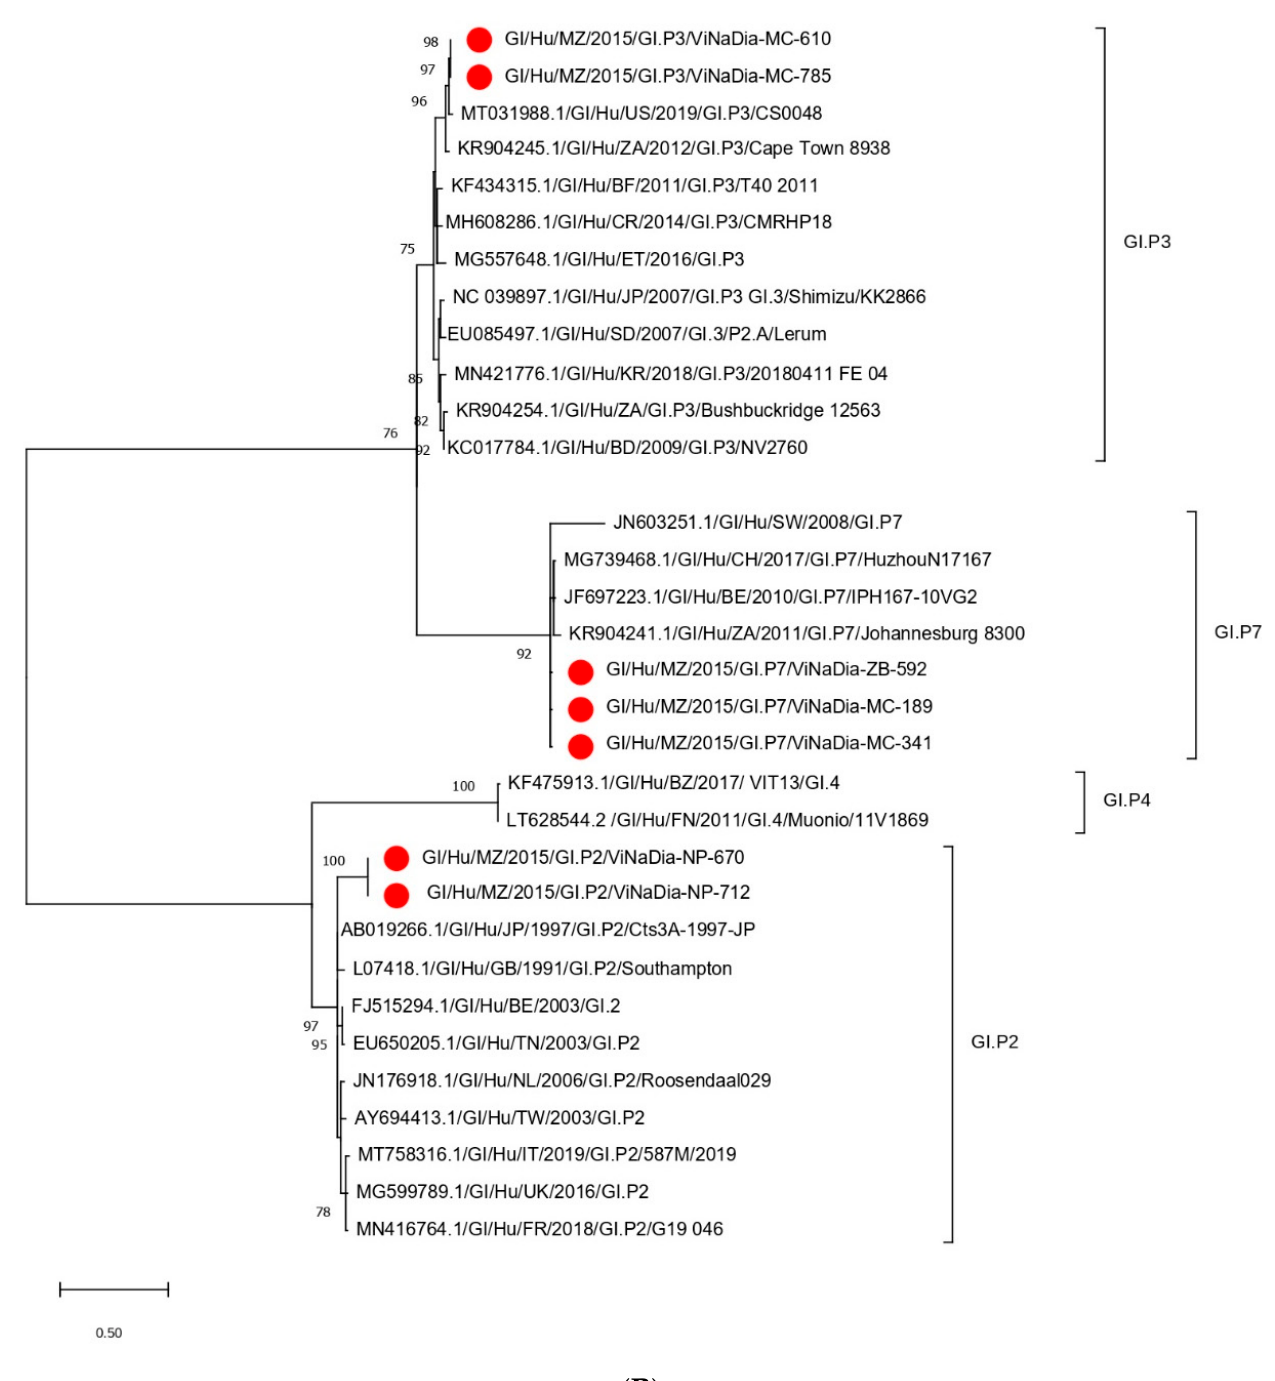
Figure 3. ( A ) Maximum-likelihood phylogenetic tree of partial VP1 gene (region C), representing seven NoV GI strains and three genotypes from Mozambique, and ( B ) maximum-likelihood phylogenetic tree of partial RdRp gene (region A), representing seven NoV GI strains and four P-types from Mozambique. Bootstrap support of >70% is indicated.